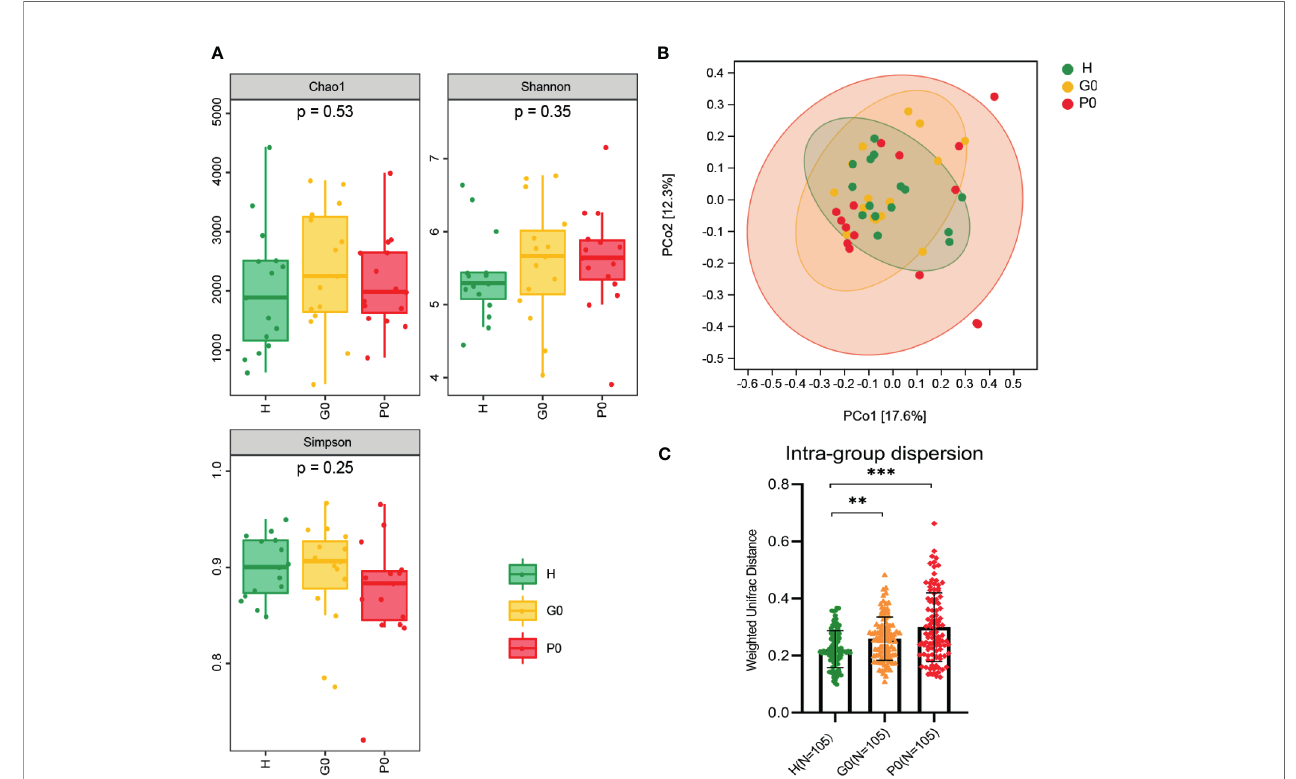
FIGURE 2 | Comparisons of alpha diversity and beta diversity among the three baseline groups, H, G0, and P0. (A) Microbial richness presented by Chao1 and microbial diversity presented by Shannon and Simpson indices. (B) PCoA based on Bray-Curtis distance exhibiting the variation of community structure in the three groups. (C) Intragroup dispersion presented by the corresponding interindividual weighted UniFrac distances for each group. **P < 0.01, ***P < 0.001 by Kruskal- Wallis test. Each color represents one group: green for H, yellow for G0, and red for